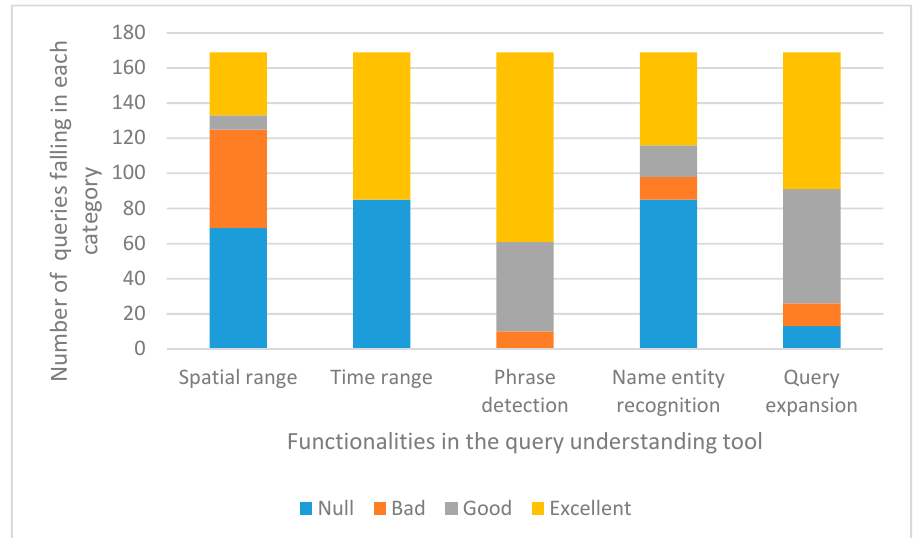
Figure 9. Evaluation of query understanding results of 169 synthetic queries.